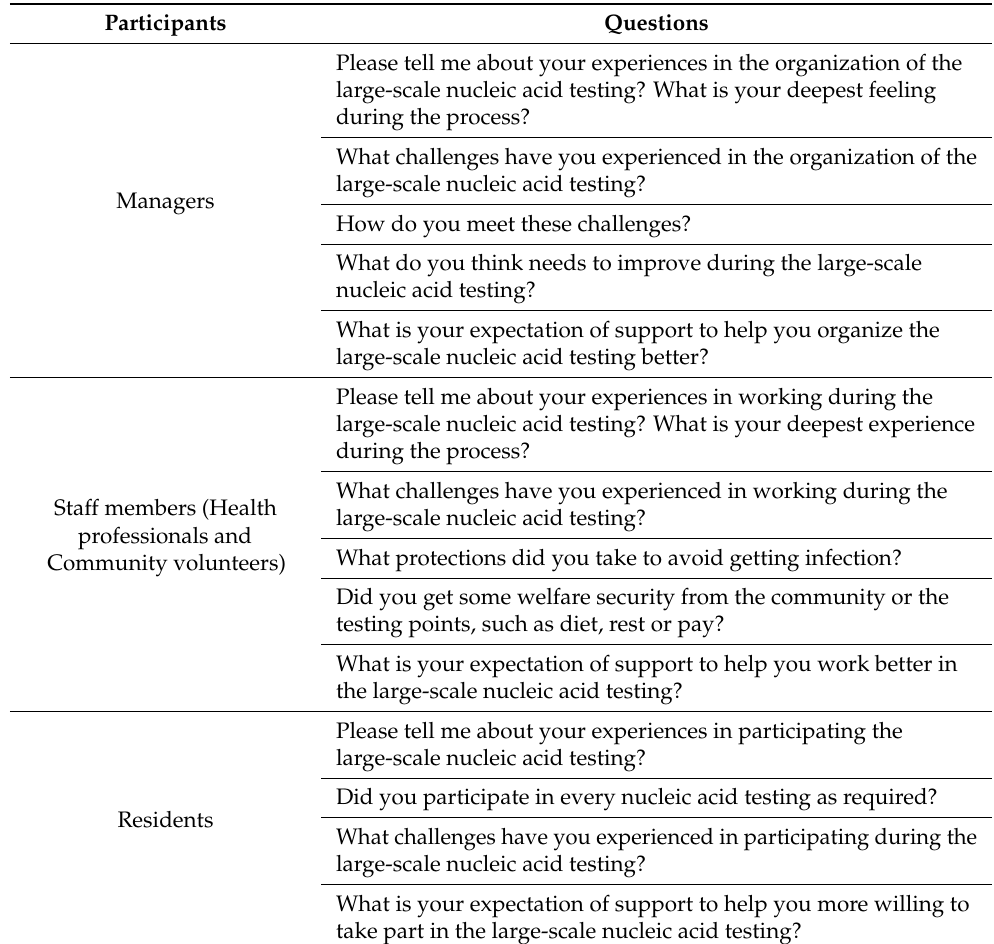
Table 1. Samples of interview